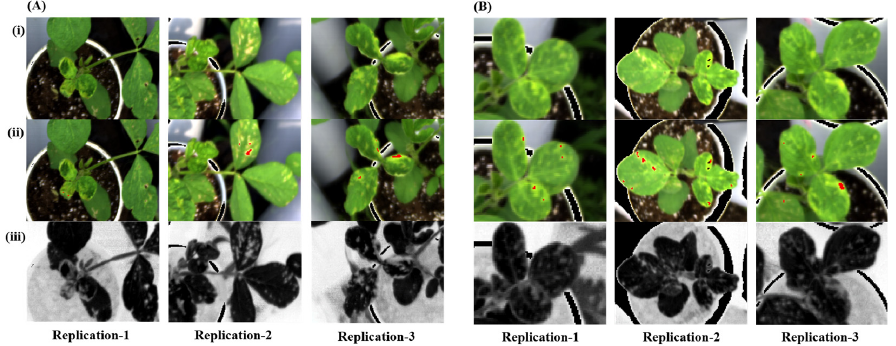
Figure 2. Images of the healthy and diseased regions before and after the analysis of the Cheongja 3-ho ( A ) and Daechan ( B ) soybean varieties: ( i ) original image, ( ii ) annotated image, and ( iii ) image obtained after analysis. Table 2. List of the formulas used to verify the significance between the multiple wavelengths.